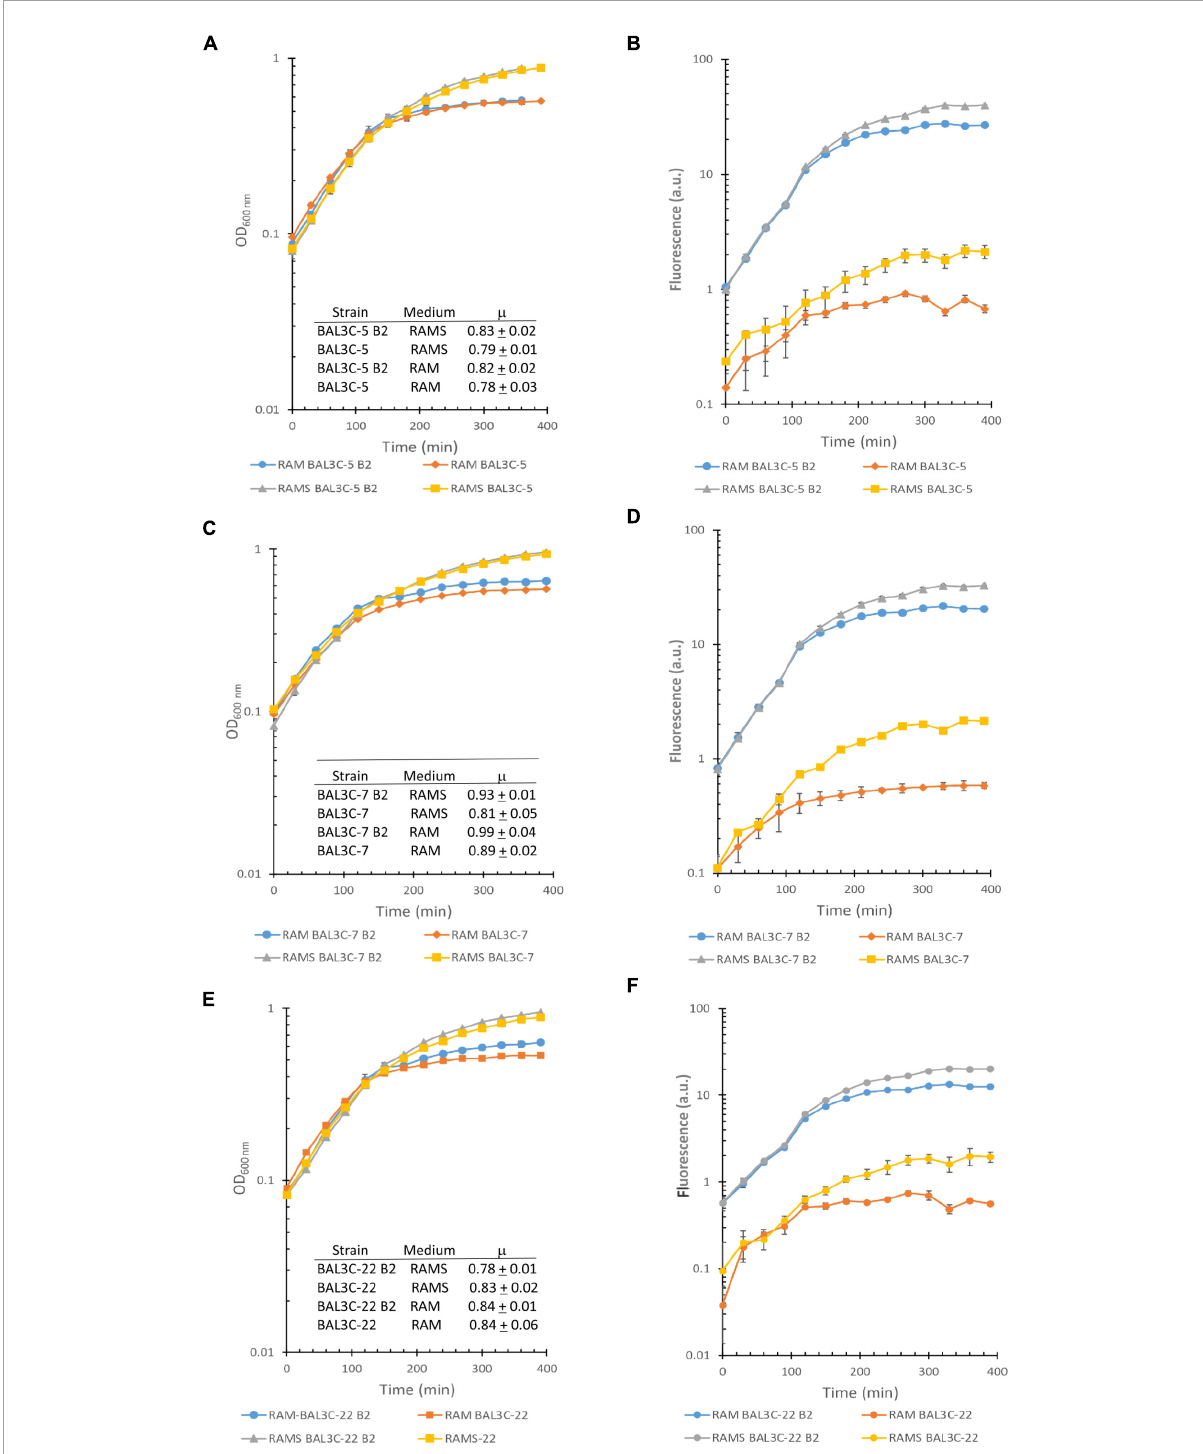
FIGURE1 Detection of riboflavin production by the Weissella cibaria strains. Real time monitoring of growth (A,C,E) and riboflavin (B,D,F) production of the different W. cibaria strains analyzed in this study [BAL3C-5 and BAL3C-5 B2 (A,B) ; BAL3C-7 and BAL3C-7 B2 (C,D) ; BAL3C-22 and BAL3C-22 B2 (E,F) in RAM or in RAMS]. In the left panels, the plots display the growth curves of each strain, with the symbols and error bars representing, respectively, the average and standard deviation of three independent experiments. Growth rate constants ( µ ) were calculated during the exponential phase for each of the strains in the two-culture medium. The µ values are expressed as mean ± standard deviation of three independent experiments. In the right panels, the plots display the riboflavin production curves of each strain. Symbols and error bars represent, respectively, the average and standard deviation of three independent riboflavin fluorescence